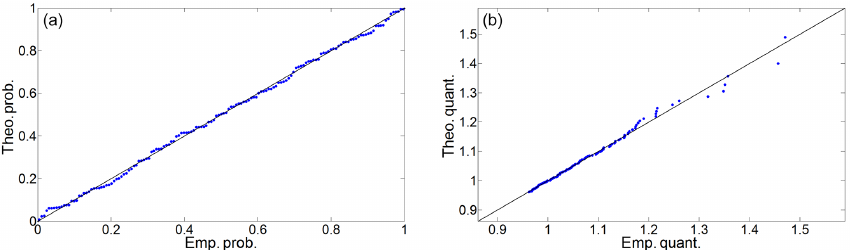
Figure 6. PP plot (a) and QQ plot (b) for GPD of SWL (threshold at 0.96mZ.H.). Hazen plotting position is used for empirical